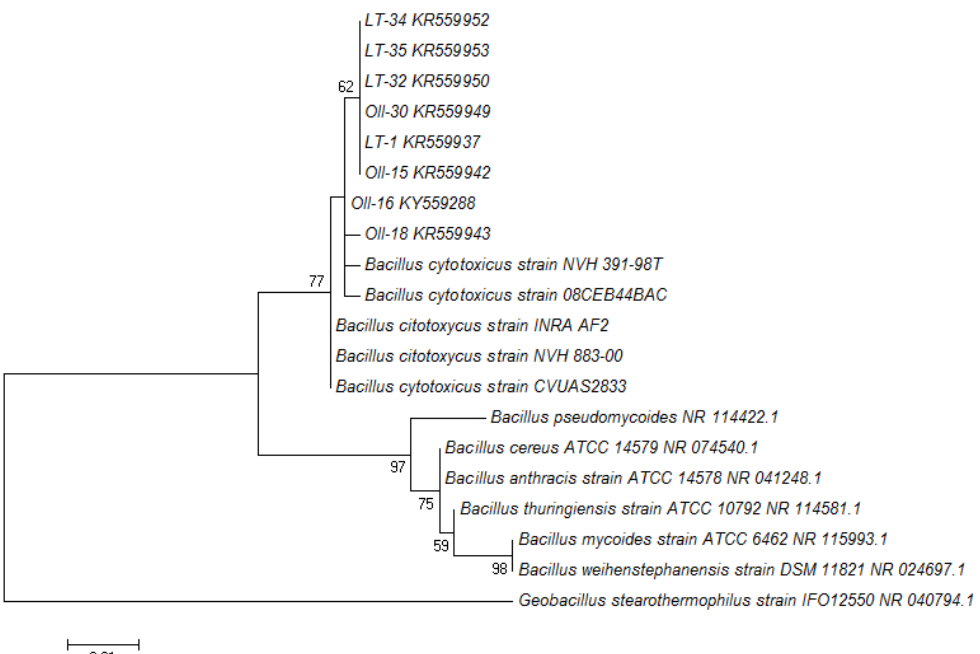
Figure 1. Phylogenetic tree of the 16S rRNA gene of the Bacillus cytotoxicus ( B. cytotoxicus ) isolated from Domuyo obtained by maximum likelihood (Kimura two-parameter (K2P) distance method). Bootstrap values (1000 tree interactions, shown in the unit of %) higher than 50 are indicated at the nodes. The scale bar represents 1% estimated phylogenetic diversity.